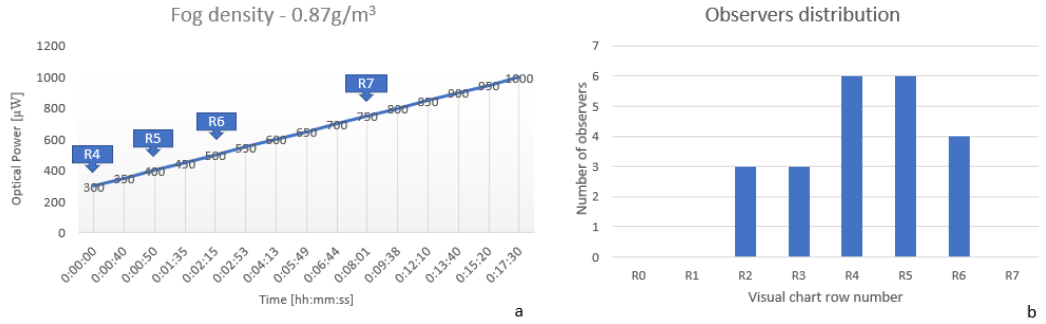
Figure 9. ( a ) Optical power and Optical Character Recognition (OCR) measurements at a fog density of 0.87g/m 3 ( b ) Observers visual acuity distribution at a fog density of 0.87g/m 3